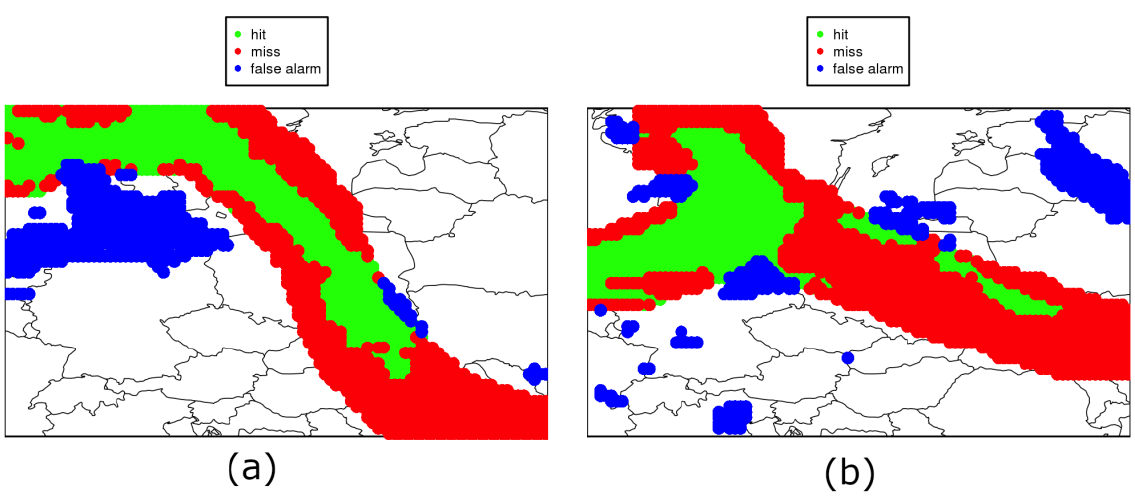
Figure 10. Results of the detection of fronts for 16 January 2019 ( a ) and 6 July 2019 ( b ).